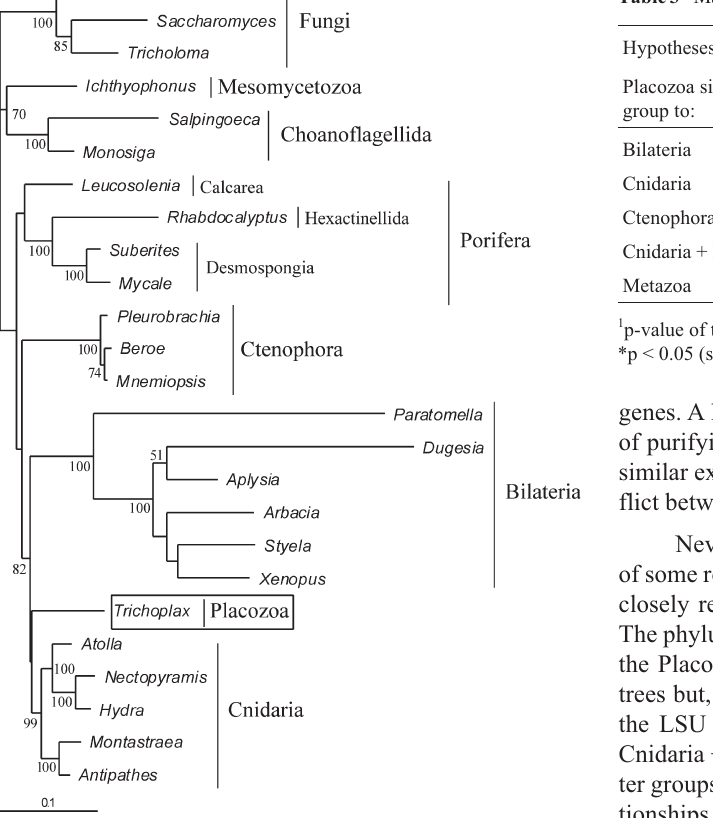
Table3 -Maximumlikelihoodtestsof apriori